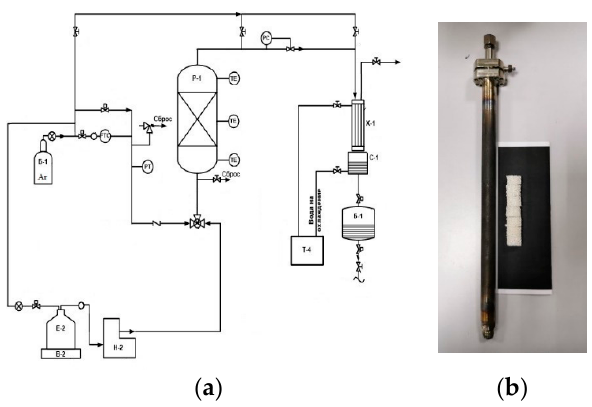
Figure 8. ( a ) Installation diagram of decreasing oil viscosity; ( b ) reactor and highly porous catalyst.